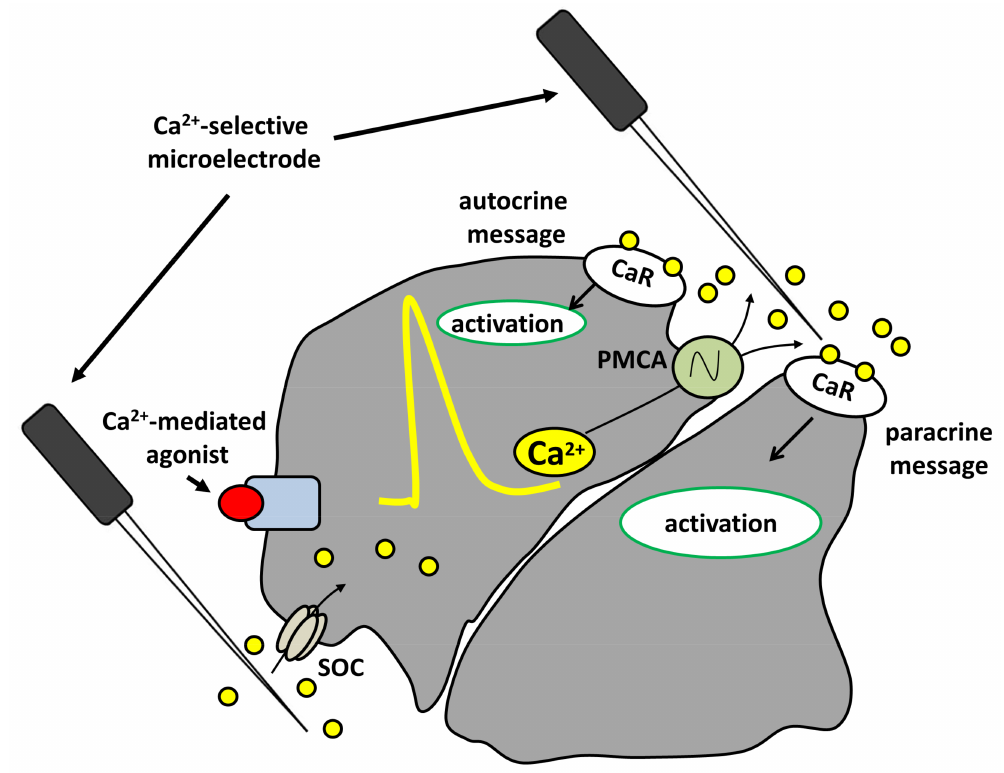
Figure 1. Schematic representation of intercellular communication mediated by the calcium-sensing Receptor (CaR) in polarized epithelial cells. When a Ca 2+ -mediated agonist (red circle) binds a specific receptor, Ca 2+ concentration (yellow line) increases within the cytosol. Extrusion of Ca 2+ via the plasma membrane Ca 2+ -ATPase (PMCA), localized at the apical membrane, might activate the CaR expressed on cells in close proximity (paracrine message) or on the same cell (autocrine message). The asymmetrical changes in extracellular Ca 2+ are the result of the polarized localization of PMCA and store-operated channels (SOCs) at the apical and basolateral membranes, respectively. These fluctuations can be recorded with Ca 2+ -sensitive microelectrodes. Modified from